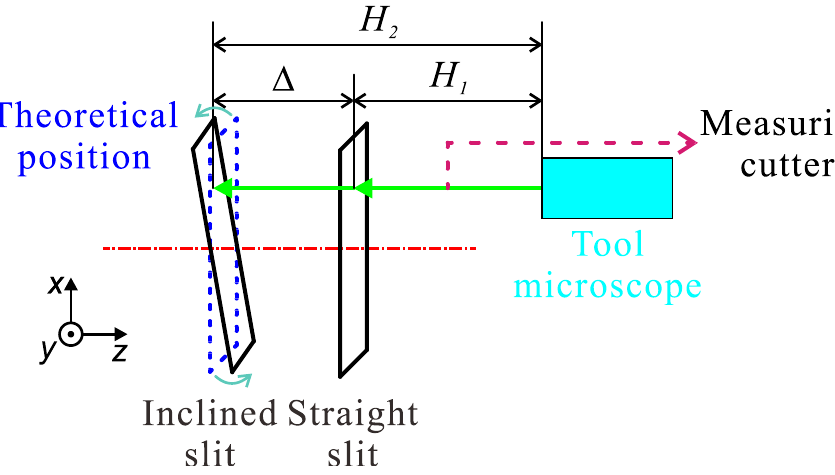
Figure 15. Principle diagram of the measurement under a tool microscope.